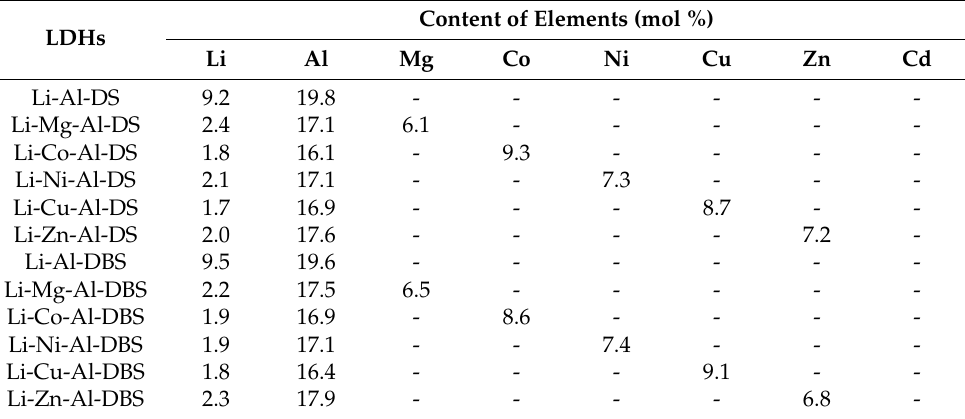
Table 1. The elemental content of surfactant (DS − and DBS − )-intercalated Li-Al and Li-M-Al (M = Mg, Co, Ni, Cu, and Zn) LDH from ICP-AES measurement.